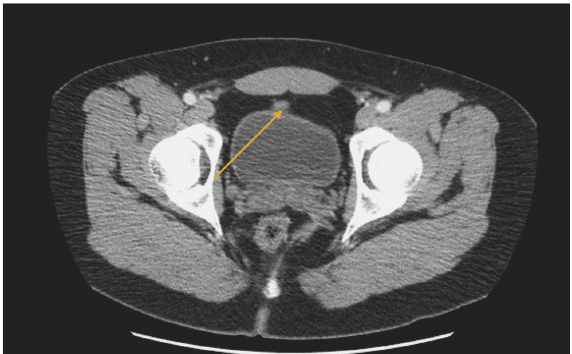
Figure 2: Computed tomography (CT) scan of the abdomen and pelvis axial section showing urachal remnant anterosuperior midline of the bladder (orange